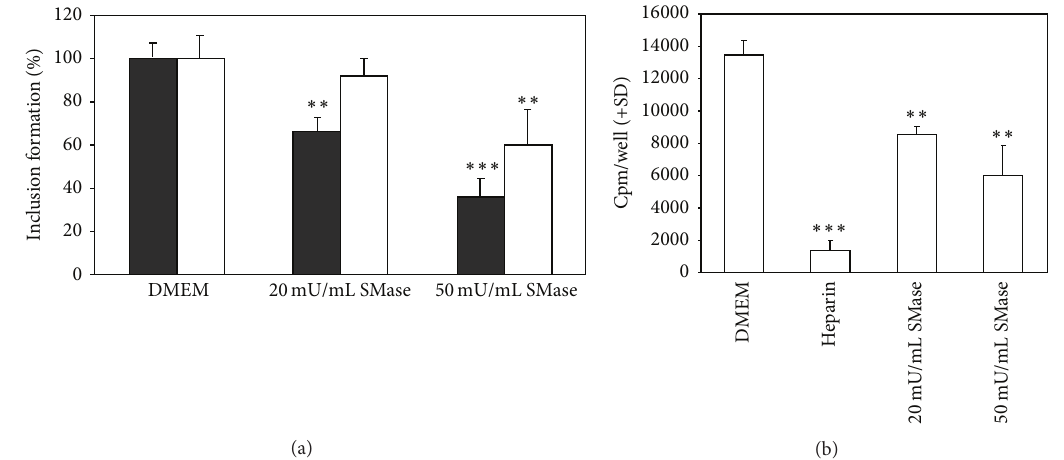
Figure 5: Impact of a pretreatment of the host cells by exogenous SMase on the entry and growth of C. pneumoniae. (a) HL cells were incubated for 30min at 37 ∘ C with either 20 or 50 mU/mL of S. aureus SMase, as indicated, either before (black bars) or after (white bars) their inoculation with C. pneumoniae (0.1 × 10 6 IFUs). Growth of C. pneumoniae was detected at 48 hours postinoculation. (b) Internalization of C. pneumoniae by HL cells pretreated with SMase (20 or 50mU/mL, final concentration), followed by inoculation with metabolically labelled bacteria. Radioactivity in cells was measured after inoculation and trypsin treatment. Heparin (500 𝜇 g/mL) inhibits attachment of bacteria to the host cells and was employed as a negative control. The error bars indicate standard deviations from triplicate wells. Student’s t -test gave values of ∗∗ 𝑃 < 0.01 and ∗∗∗ 𝑃 < 0.001 for the difference between the cells treated with SMase and controls in DMEM.